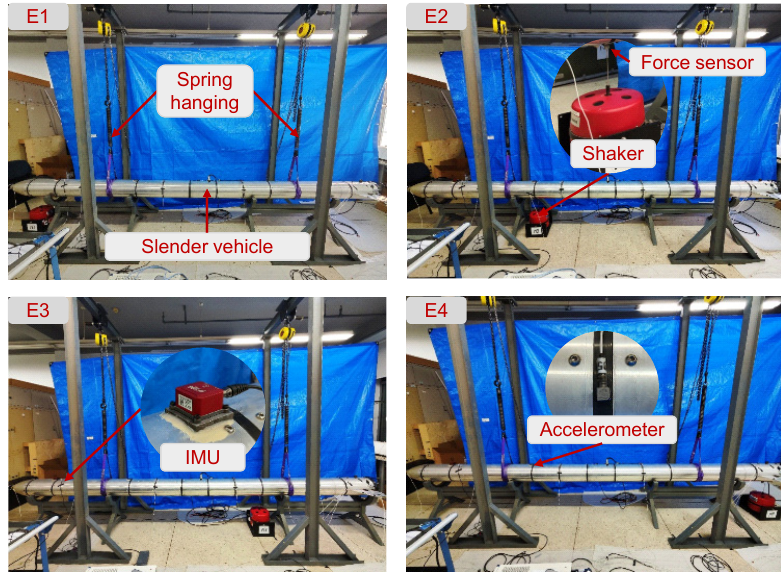
Figure 20. FRTs of shaker excitation.